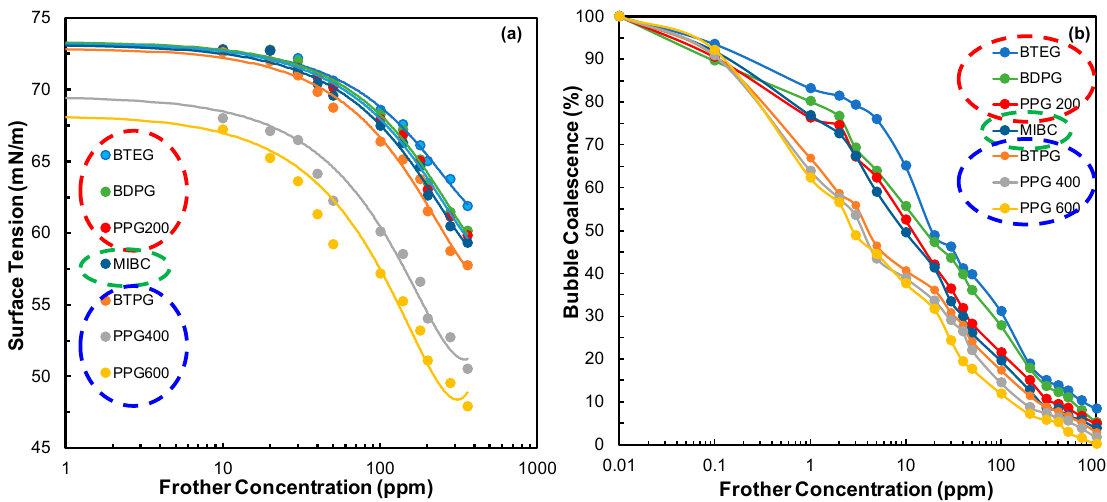
Figure 2. Results for ( a ) surface tension measurements ( b ) bubble coalescence of frothers [7].